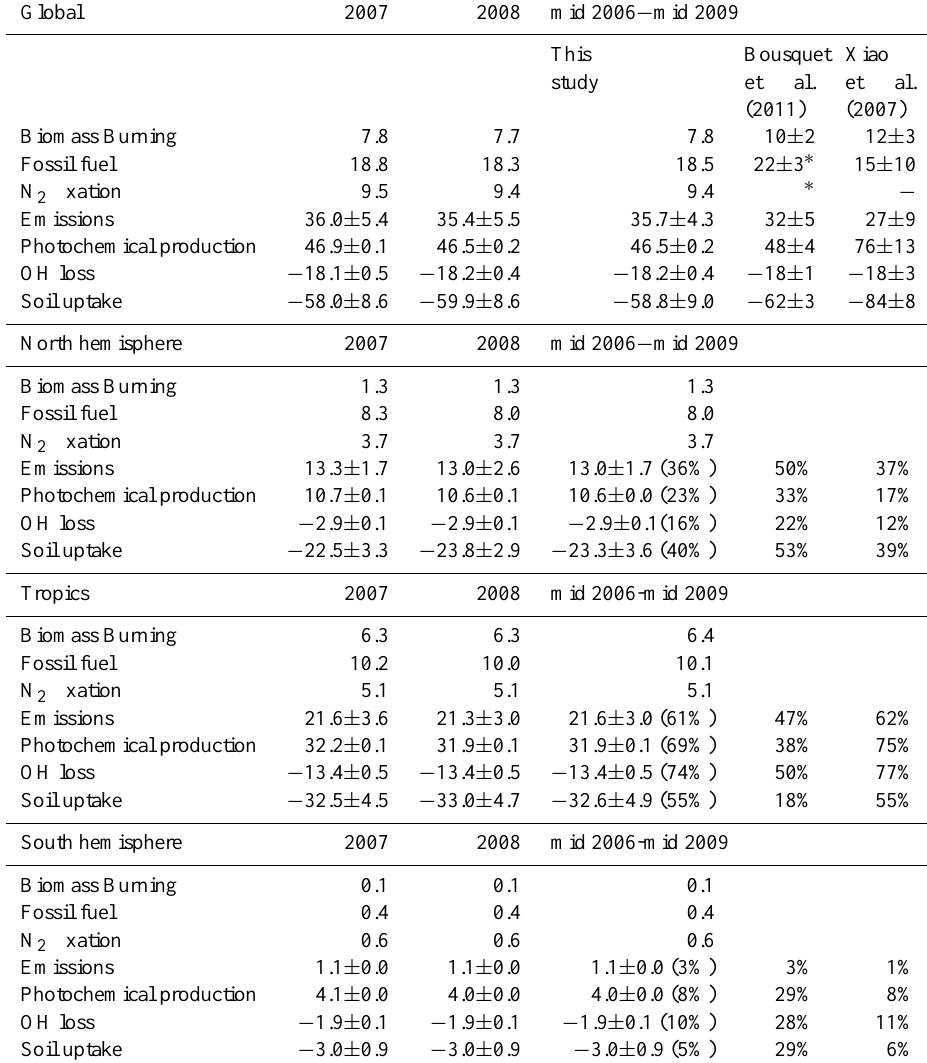
Table 4. H 2 budget per process in Tg yr − 1 ( ∗ in Bousquet et al. (2011) the fossil fuel and N 2 fixation related emissions are inverted together). The indicated error represents the maximum spread of the scenarios S1 to S4 compared to S5 for this study, the standard deviation of the sensitivity inversions for Bousquet et al. (2011) and for Xiao et al. (2007), the model uncertainties, absolute calibration error and errors in the assumed fossil fuel source strength. The % represent the part of each regional term in the global term. The separated emission terms are not associated with error in this study as we did not perform several sensitivity